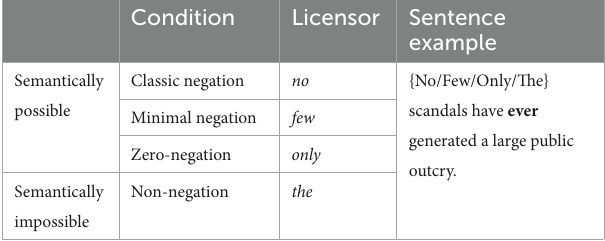
TABLE 3 Four conditions in Experiment 2 and example stimuli (adapted from Xiang et al.,